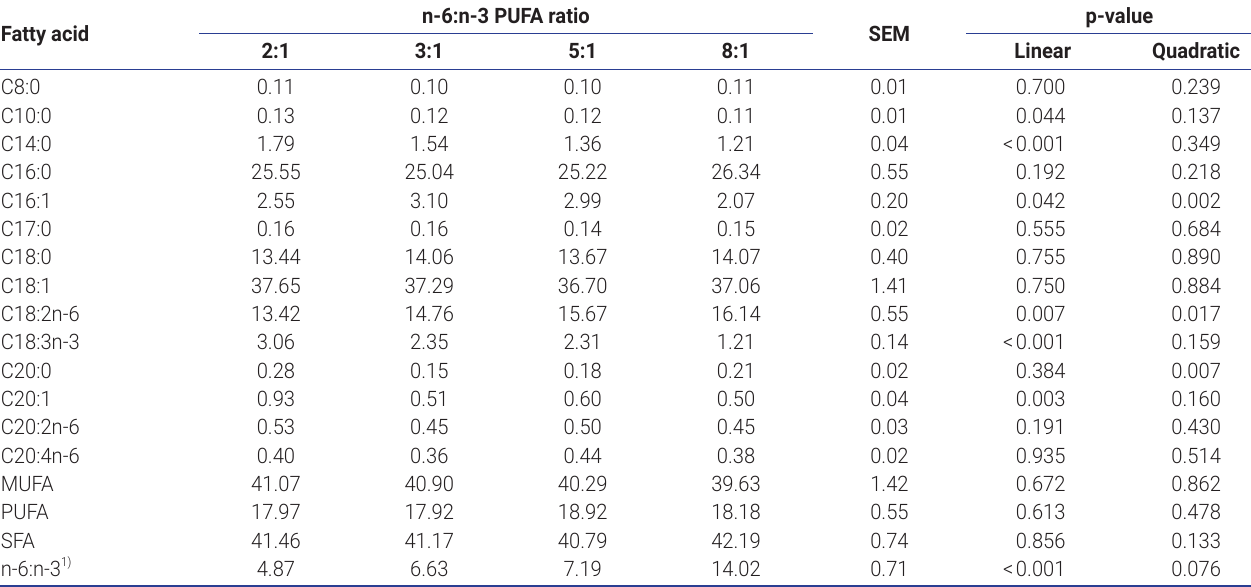
Table 6. Effects of dietary n-6:n-3 PUFA ratios on fatty acid composition of the LT of pigs (% total fatty acids) Fatty